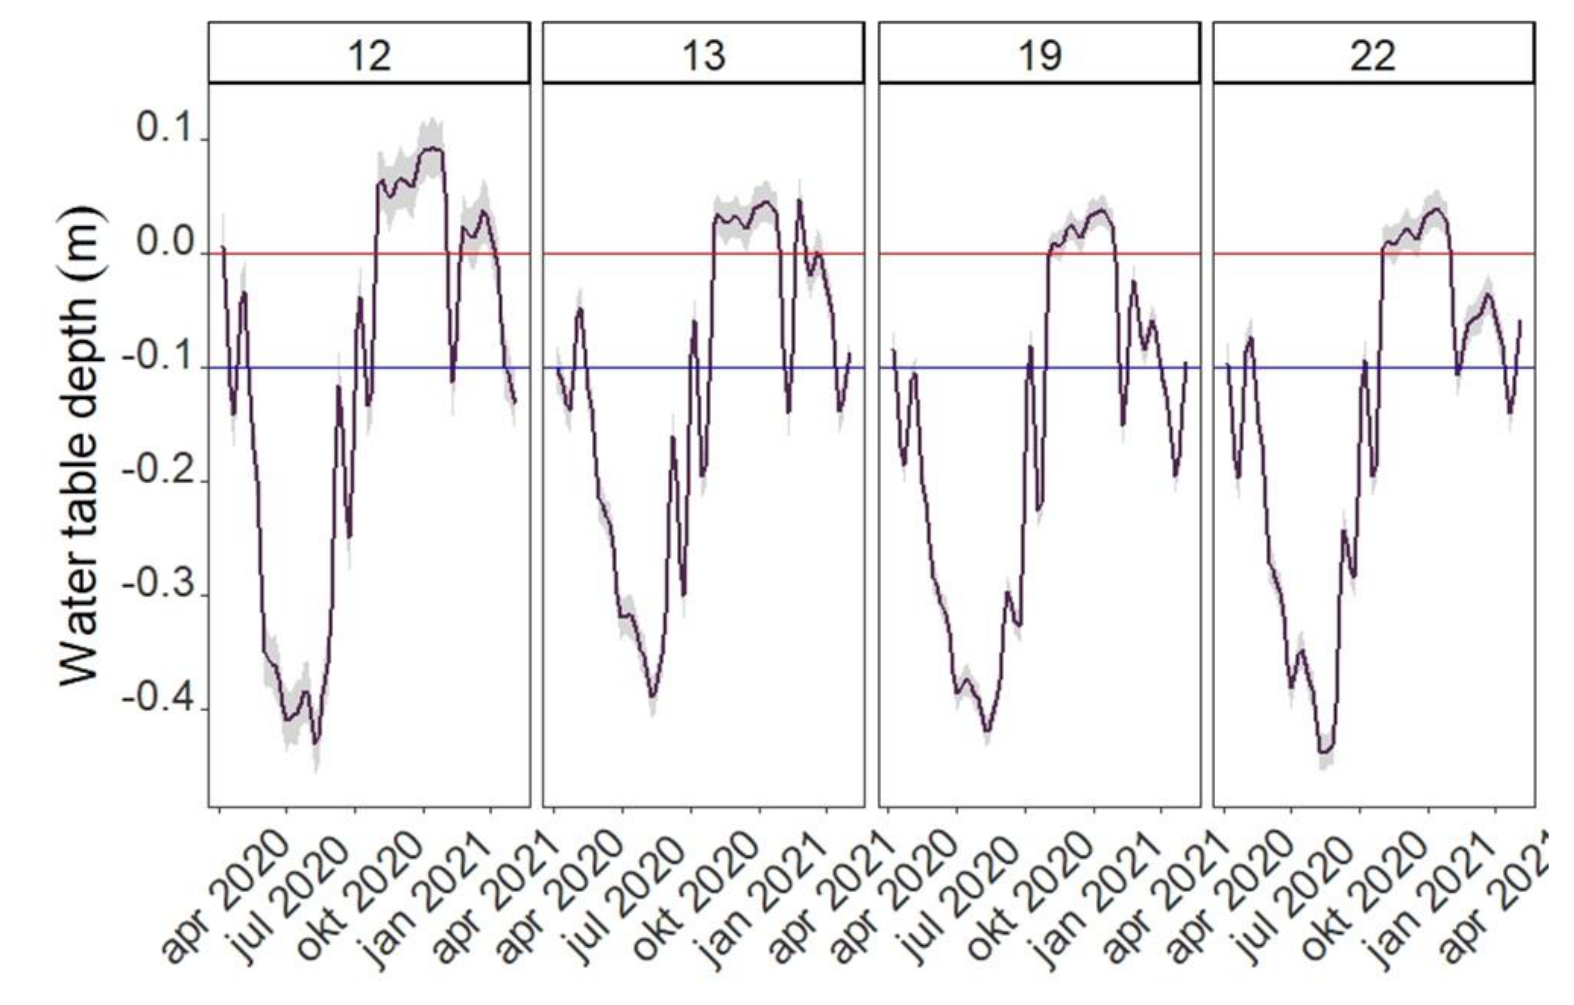
Figure A1. Records of hourly logged water table depth on four of the eight